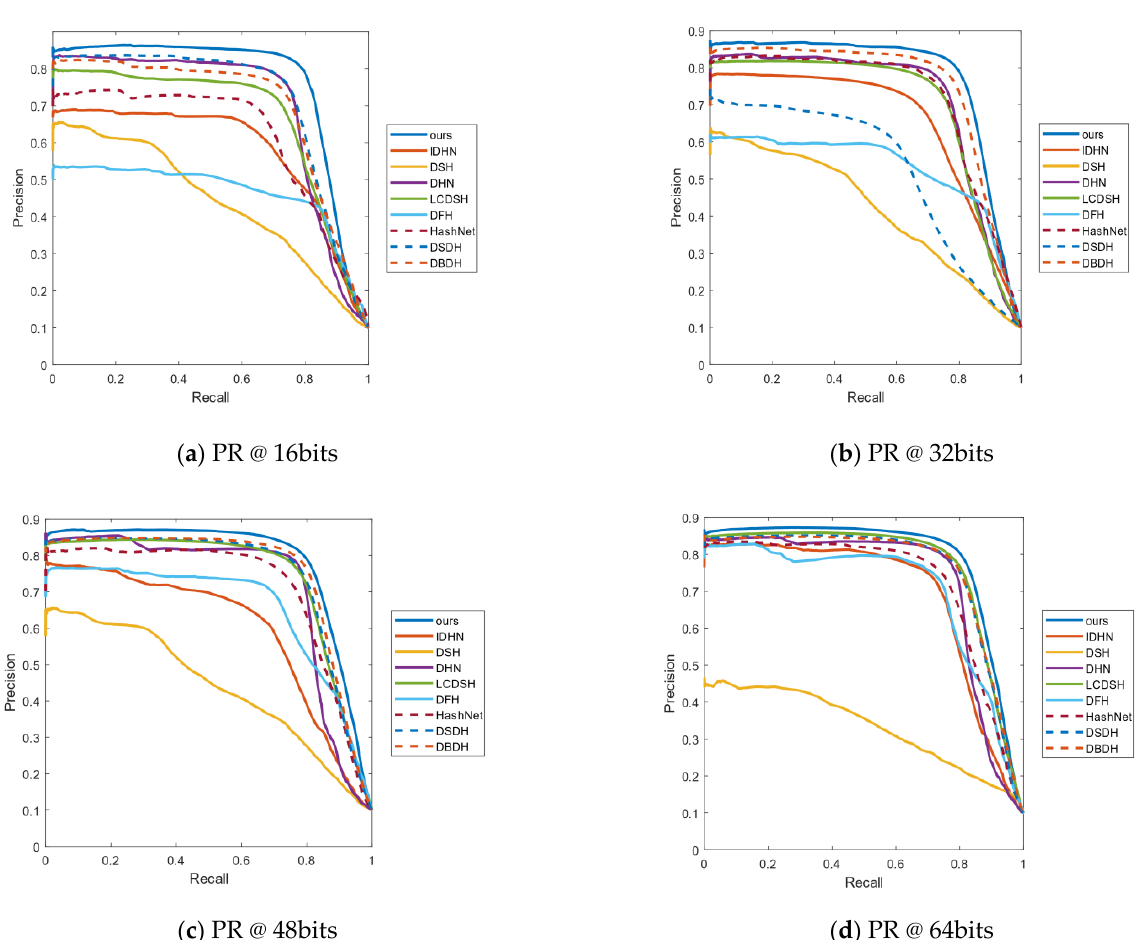
Figure 3. ( a – d ) represent the PR curves on CIFAR-10 of all algorithms when the length of the hash code is 16 bits, 32 bits, 48 bits and 64 bits, respectively.